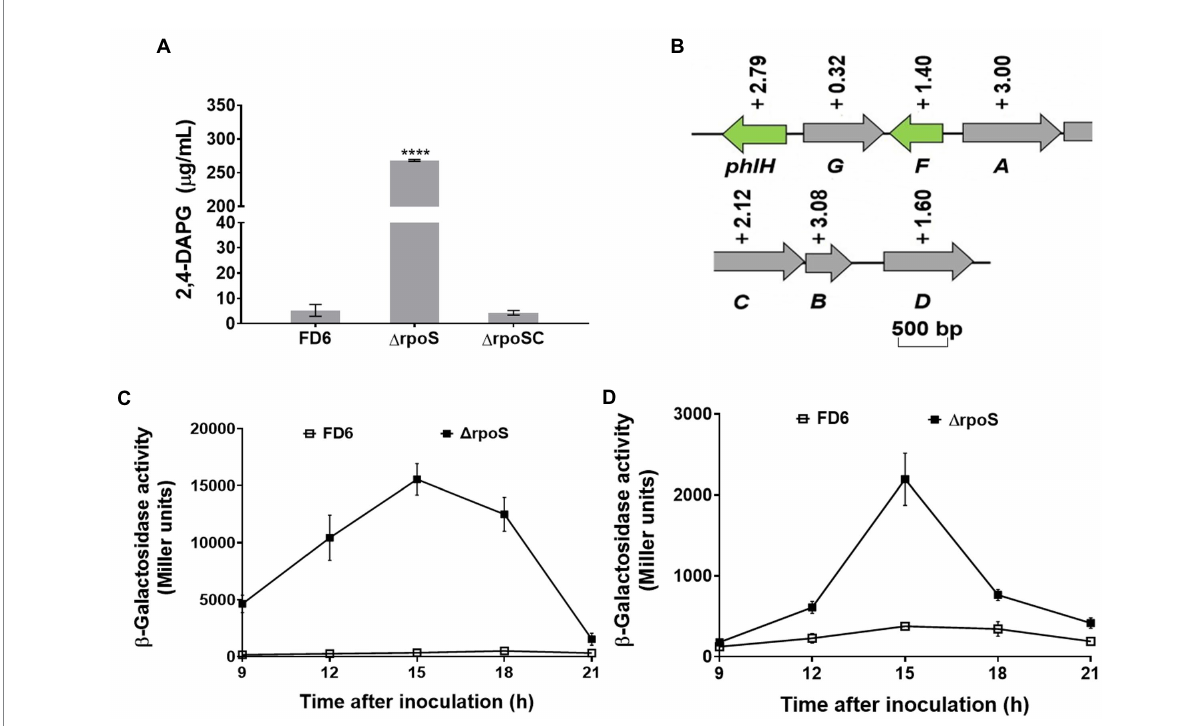
FIGURE 3 Negative modulation of 2,4-DAPG synthesis and operon expression by RpoS. (A) 2,4-DAPG biosynthesis was quantified using HPLC. (B) Effect of RpoS on the transcript level of the 2,4-DAPG synthesis genes in Pseudomonas protegens FD6. Gray and green indicate that these genes are involved in biosynthesis and regulation, respectively. (C,D) Deletion of rpoS significantly increased the expression of the phlA-lacZ and phlA ′ - ′ lacZ fusions. Error bars show mean ± standard deviation. **** p <